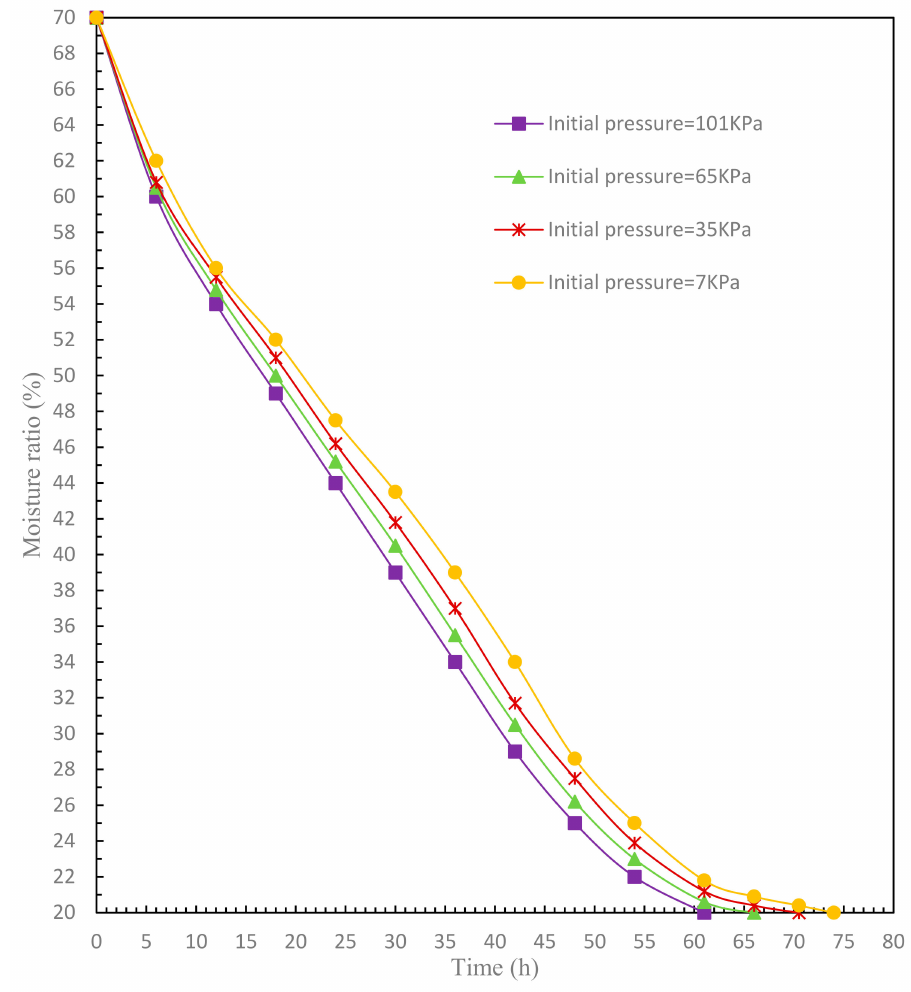
Figure 7. Drying time under different initial